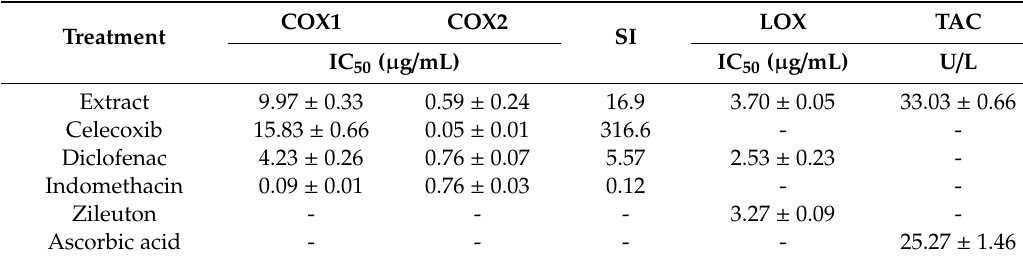
Table 2. In vitro inhibitory activity of H. campechianum flower extract against COX1, COX2, LOX and its total antioxidant